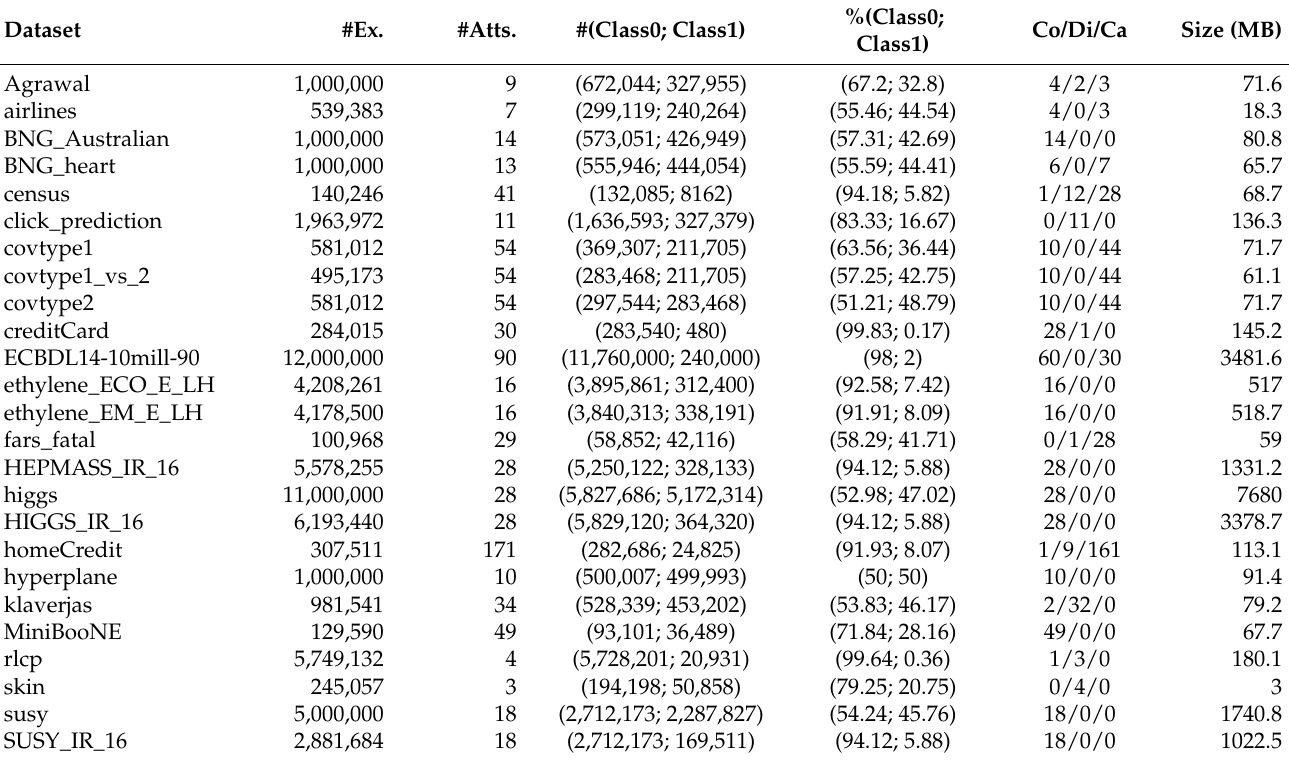
Table 2. Datasets